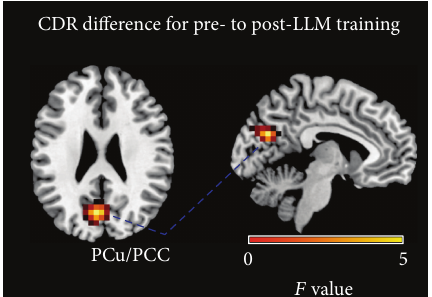
Figure 2: Grand average of eLORETA solutions (i.e., CDR at PCu/PCC voxels at 𝑃 < 0.05 , corrected) modelling the EEG source for delta band in the LLM group on the corresponding axial (left view) and sagittal (right view) generic MRI slices. The left side of the maps (left view) corresponds to the left hemisphere. The power estimatewasscaledbasedontheaveragedmaximumvalueindicated in the scale bar. Similar illustrations but of fewer voxels apply for the theta, beta 1, and beta 2